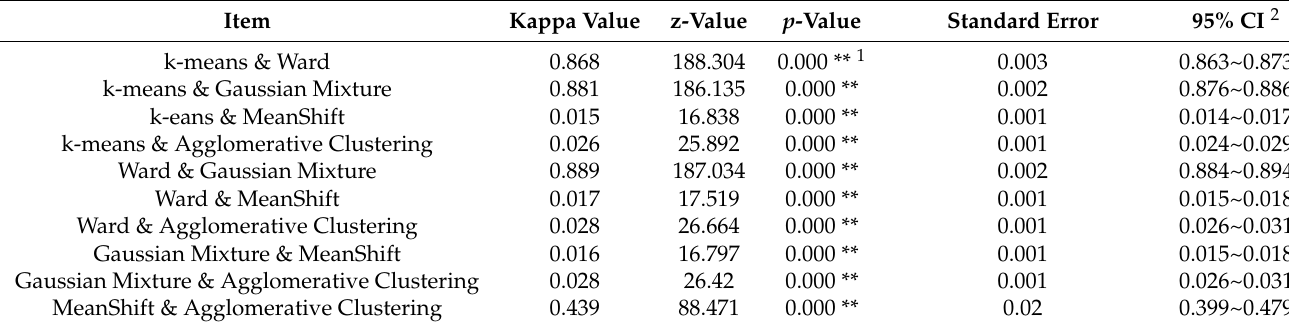
Table 5. Kappa consistency test results of clustering results.